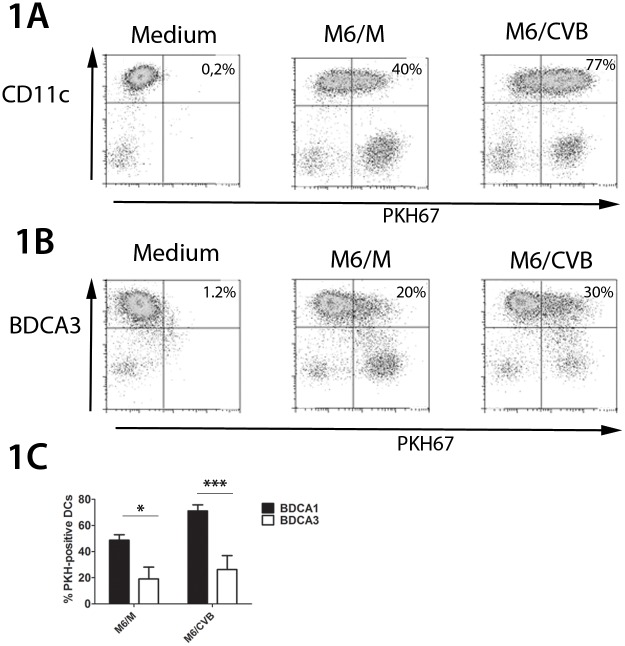
BDCA1+ mDCs more efficiently phagocytose murine Min6 cells compared to BDCA3+ mDCs.
A) BDCA1+ mDCs or B) BDCA3+ mDCs were co-cultured overnight (o/n) with PKH67-labeled mock- or CVB-infected Min6 cells (M6/M and M6/CVB, respectively) stained for the CD11c or BDCA3 and analyzed by flow cytometry on viable, single cells (See S1 Fig). Percentages in upper right corner represent the percentage of DCs that has engulfed Min6 material. This was calculated as follows: percentage PKH+ DCs/total DCs (i.e. total CD11c positive cells or total BDCA3 positive cells) C) DCs were analyzed as in A) and B), shown is average + SEM for >3 donors. * p<0.05, *** p<0.001 determined by ANOVA and post-hoc Tukey test.